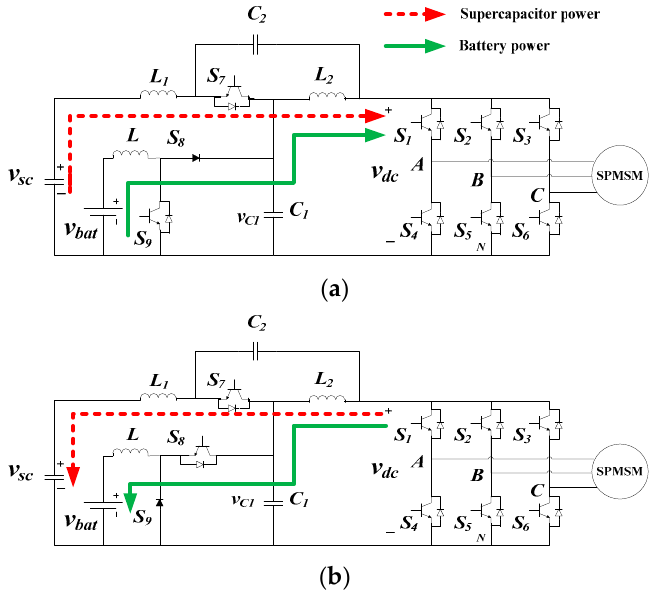
Figure 2. Power flow direction during the high-power mode operation: ( a ) traction mode ( b ) regenerative mode.